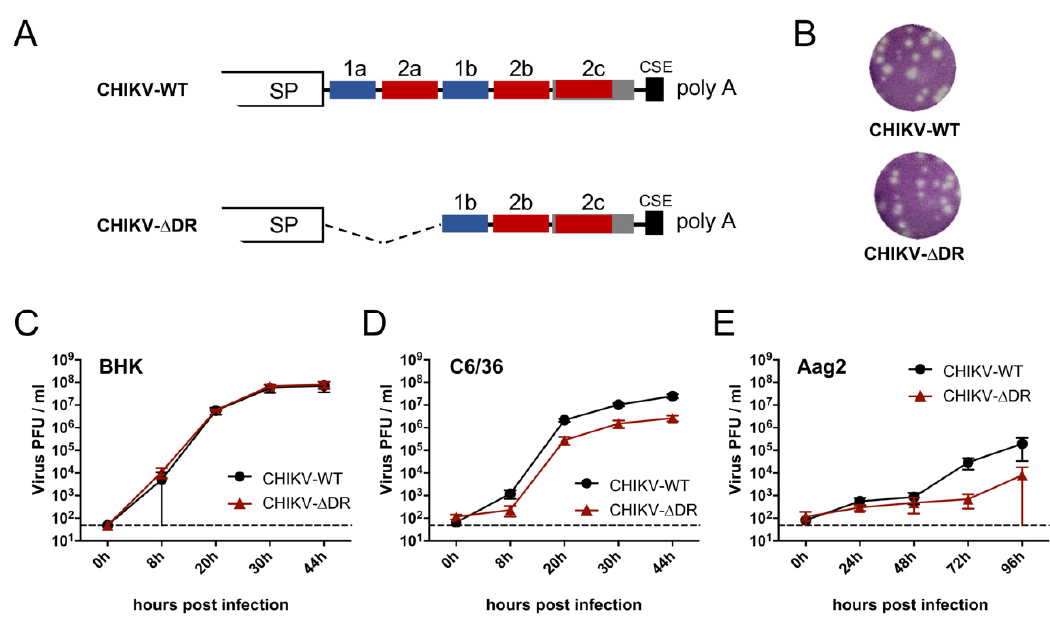
Figure 1. Growth kinetics of wild-type and ∆ DR mutant CHIKV in different cells. ( A ) Schematic drawing of the 3 (cid:48) UTRs of wild-type and mutant viruses. For CHIKV- ∆ DR, 130 nt encompassing the DR elements 1a and 2a were deleted. SP = structural protein coding region: CSE = 19 nt long conserved sequence element directly adjacent to the poly A tail. ( B ) Plaque morphology of CHIKV-WT and CHIKV- ∆ DR in Vero cells. Infected cells were overlaid with agarose. At two days post infection, cells were fixed and subjected to crystal violet staining. ( C – E ) Growth kinetics of CHIKV-WT and CHIKV- ∆ DR in vertebrate (BHK) and mosquito (C6/36, Aag2) cells. Cells were infected at an MOI of 0.1. Quantification of virus released into the supernatant was performed by titration in BHK cells. Data represent Mean ± SD of triplicate infection experiments. Dashed lines: detection